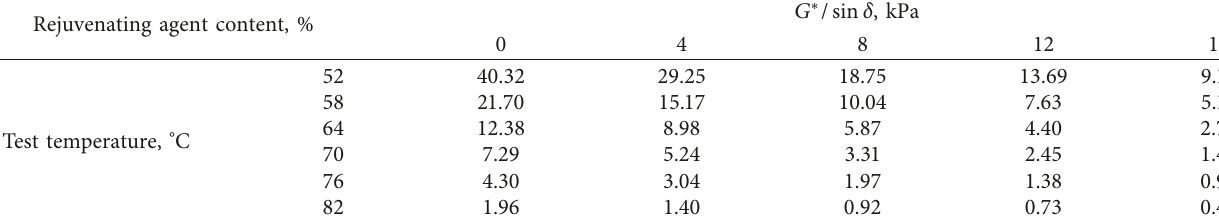
Table 9: Test results of G ∗ /sin δ .